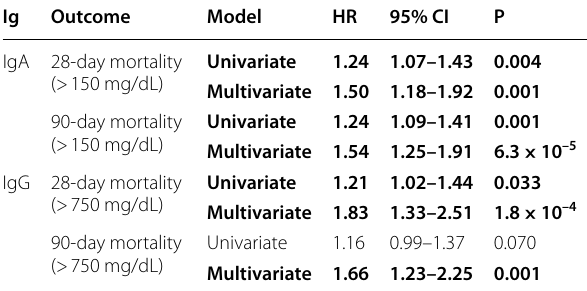
Based upon the restricted cubic spline for IgA > 150 was included ( N for IgG > 750 ( N 294) = All values were Z-standardized—HR for 1 SD Both multivariate Cox proportional hazards regression analyses were adjusted for clinical characteristics which were associated with 28- and 90-day mortality with a p value of < 0.0001: age, shock, baseline SOFA score, creatinine, platelets, cardiovascular comorbidities, renal comorbidities and COPD, see